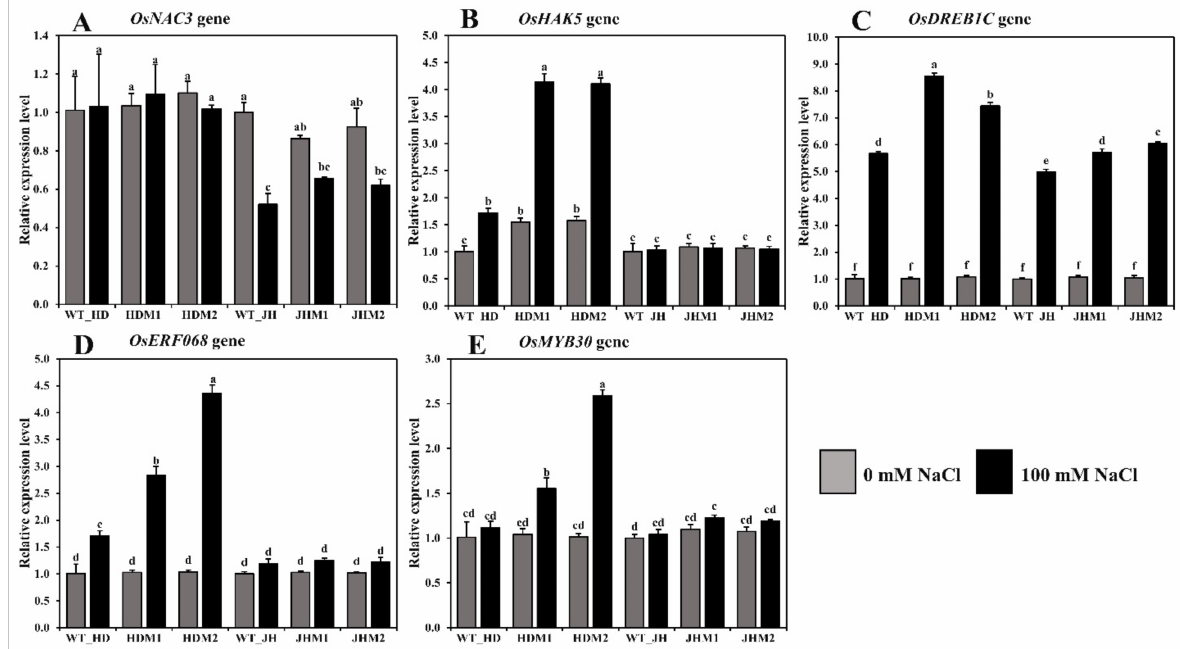
Figure 6. Relative expression of some salinity-related genes in rice. The rice cultivars Huaidao#5 (WT_HD) and Jiahua#1 (WT_JH) were the experimental control (nontreated) for their respective mutant lines, and OsActin was an internal reference. ( A ) OsNAC3 ; ( B ) OsHAK5 ; ( C ) OsDREB1C ; ( D ) OsERF086 ; ( E ) OsMYB30 gene expression in folds (2 − ∆∆ CT ) methods. Data are shown as the mean and standard deviation of 3 biological replicates and 3 technical replicates. Data with different